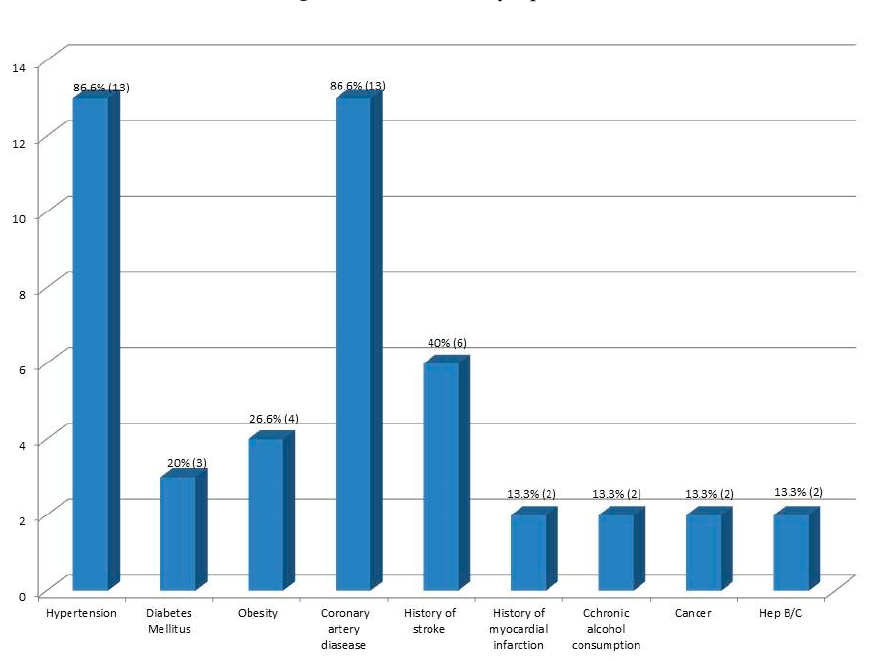
Figure 1. Associated symptoms.